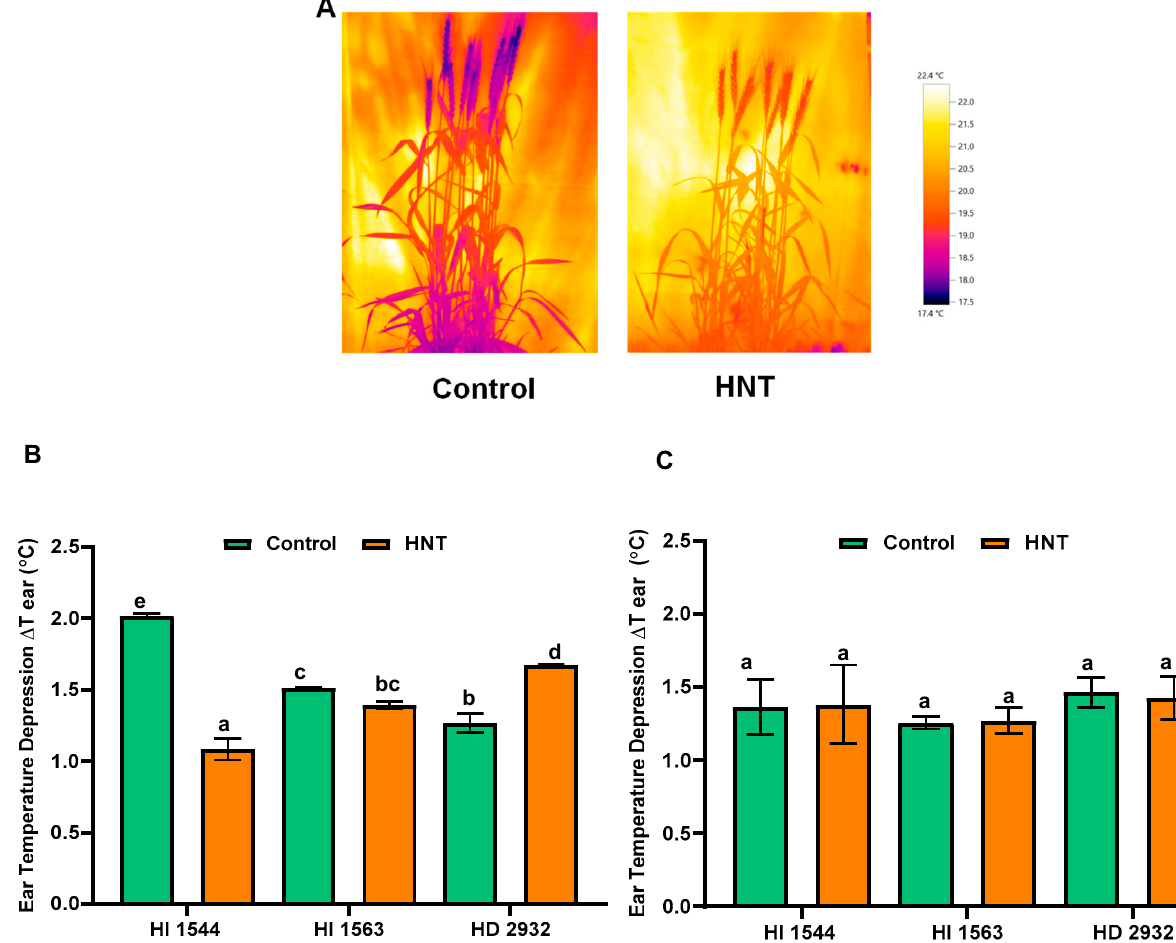
Figure 2. ( A ) Infra-red thermal images of HI 1563 under control and HNT conditions at 10 DAA. ( B , C ) Ear temperature depression of wheat genotypes grown under control and HNT conditions at 10 and 20 DAA. Ear temperature depression was defined as the difference between air temperature and ear temperature. Values show mean ± SE. Data were obtained from three replications of each genotype. The separation of means was carried out using Duncan’s post hoc test ( p < 0.05). Means with different letters are significant.